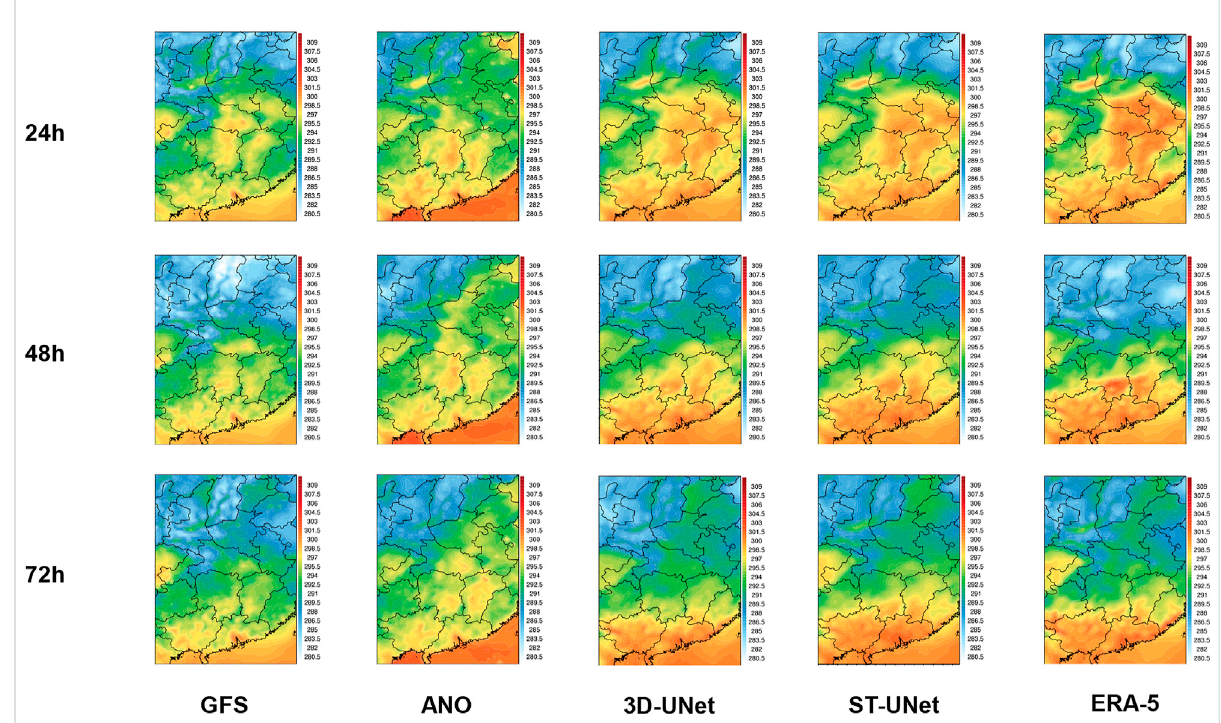
FIGURE 7 Thedistributionsof2-mtemperatureontheforecasttimeof24,48,and72 h,includingGFS,ERA-5,andcorrectedresultsfromANO,3D-UNet, and